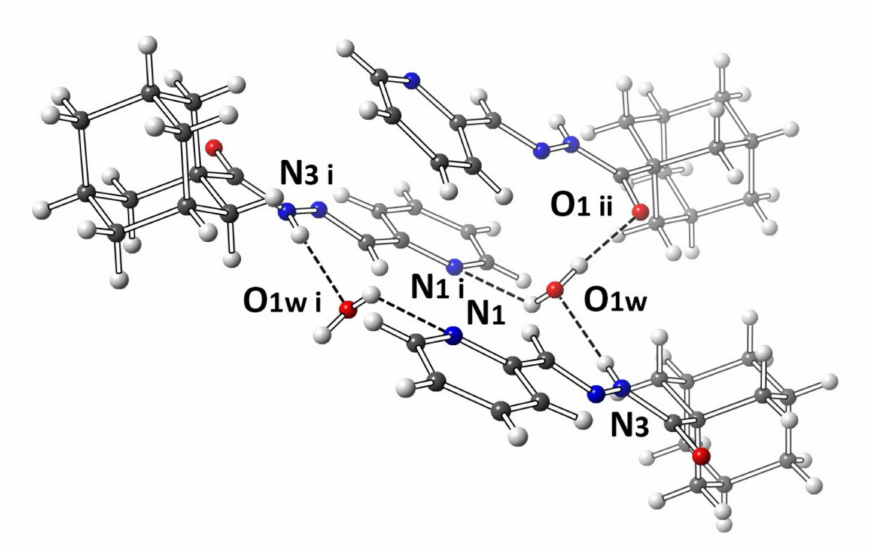
Figure4. Molecularplotof APH showsthedi ff erentintermolecularinteractionsbetween APH andwater moieties. Only one asymmetric unit interaction is shown, as the other unit is symmetrically equivalent.